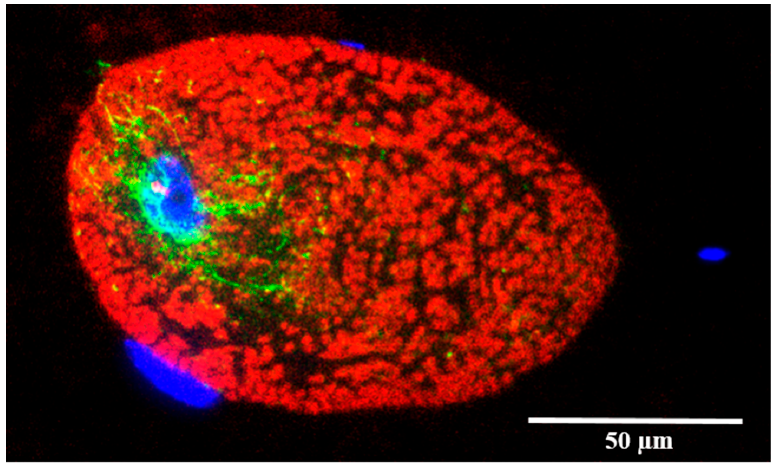
Figure 7. Epifluorescent image of an almost mature hagfish GTC in a fixed and paraffin-embedded slime gland. Fluorescently labelled IF (red) are abundant throughout the GTC cytoplasm, occupying most of the space within this mature GTC, while MTs (green) appear to be most numerous in the area around the cell’s nucleus (DAPI, blue). Nuclei of three other non-GTC cells can be seen in blue [52].